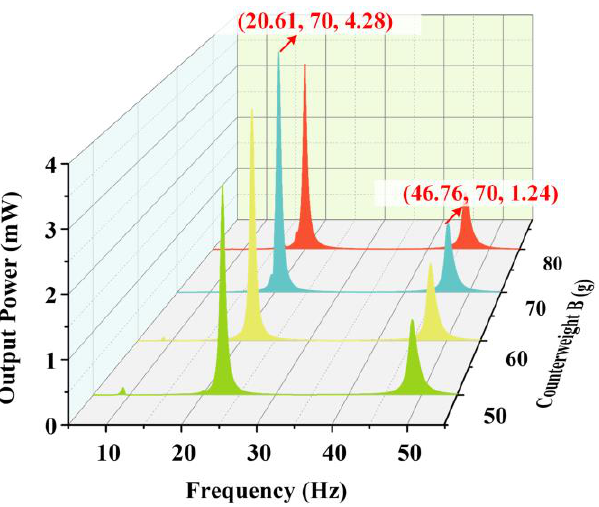
Figure 13. The total output power of the harvester with different weights of counterweight B.